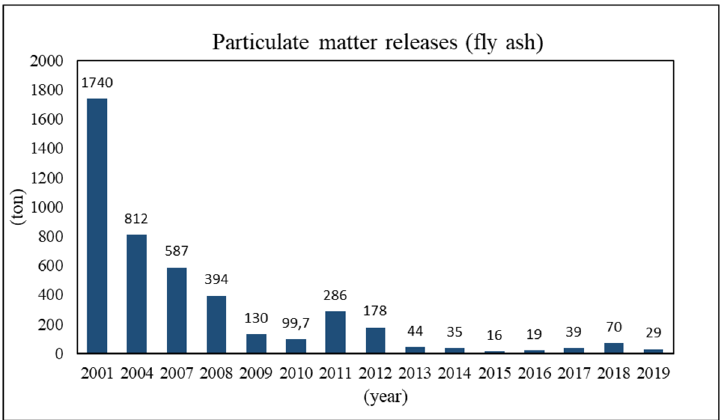
Figure 1. Particulate matter released (2001–2019).